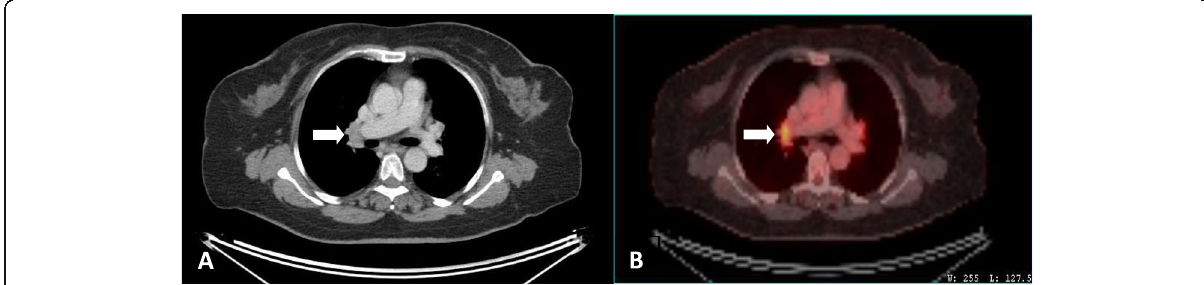
Fig. 5 Fifty-two-year-old patient presented with history of right ovarian malignant lymphoma underwent surgical resection and received CTH, for follow-up. CECT reveals enlarged bilateral hilar LNs ( a ). PET-CT ( b ) shows bilateral hilar FDG avid LNs; the largest is on the right side measuring 19 × 13 mm with SUV max 6.46, consistent with a score of 5b on the five-point